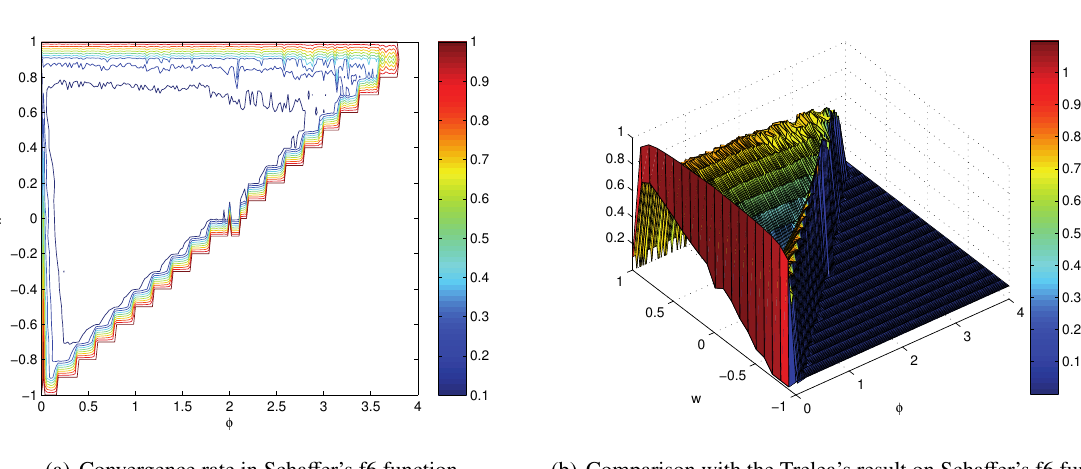
Figure 15: Convergence rate in Scha ff er’s f6 function and the major discrepancy landscape between Fig. 12(a) and the right subgraph of Fig. 2 in [31] on Scha ff er’s f6 function.